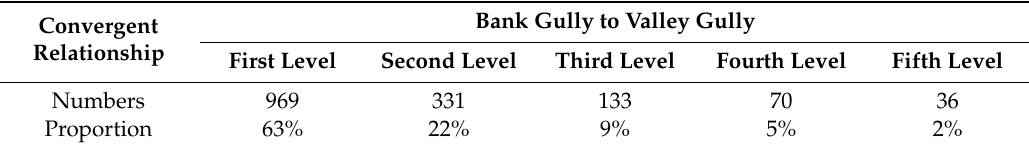
Table 5. Convergent relationship from bank gullies to di ff erent levels of valley gullies. Bank Gully to Valley Gully Convergent Relationship First Level Second Level Third Level Fourth Level Fifth Level Numbers 969 331 133 70 36 Proportion 63% 22%